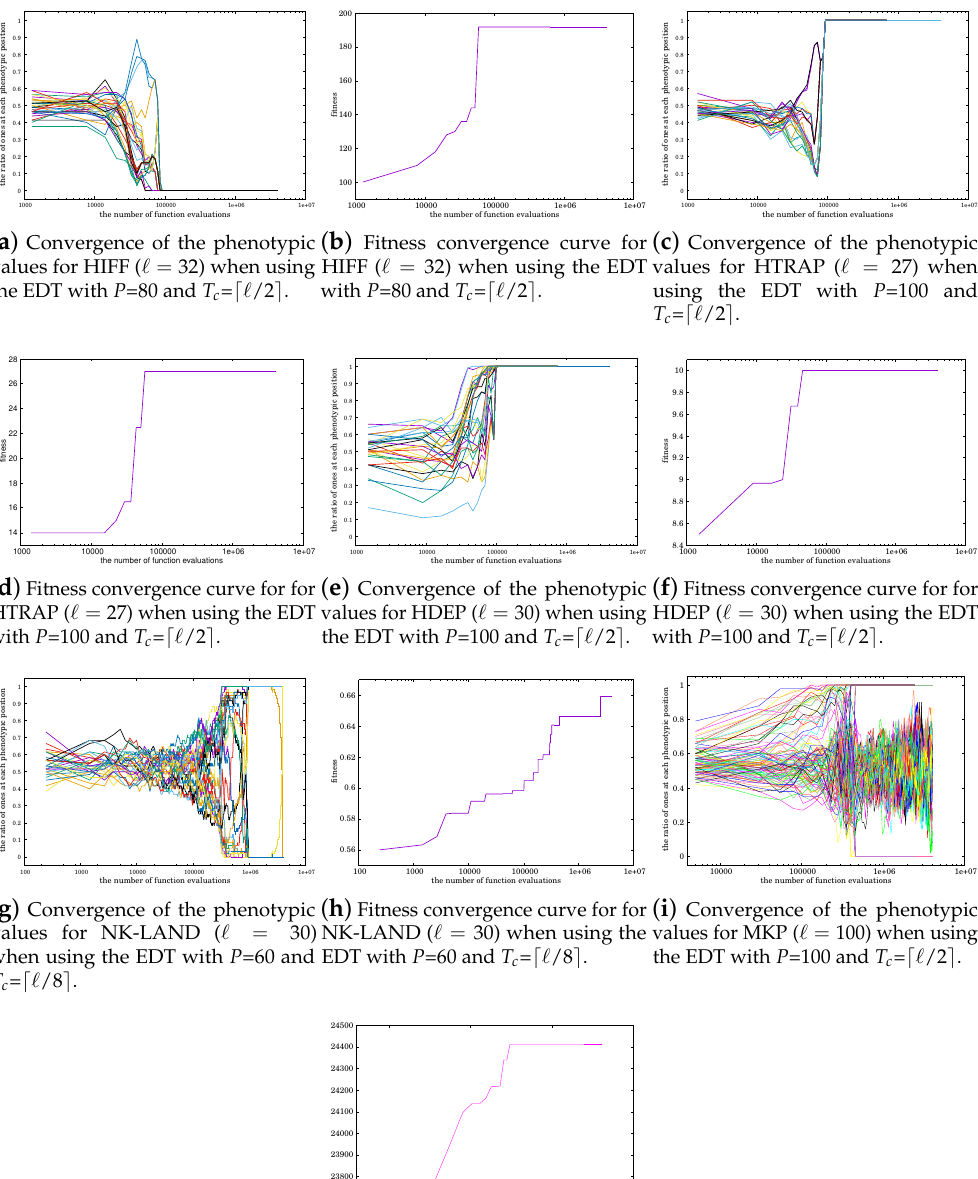
( j ) Fitness convergence curve for for MKP ( (cid:96) = 100, α = 0.25) when using the EDT with P =100 and T c = (cid:100) (cid:96) /2 (cid:101) . Figure 7. The convergence of the phenotypic values when the problem was successfully solved, and fitness convergence curves for the